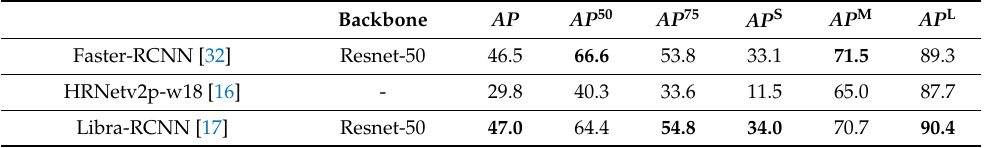
Table 2. Test results on ice environment traffic sign detection benchmark (ITSDB) with HRNet and Libra-RCNN under the Faster-RCNN